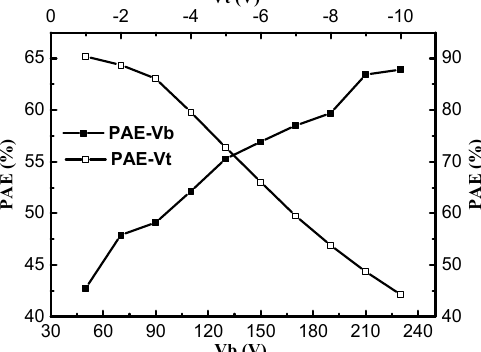
Figure 3. The effect of structural parameters V b and V t on PAE.